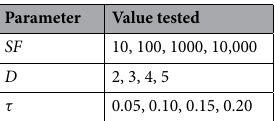
Table 6. Parameter values in the calibration